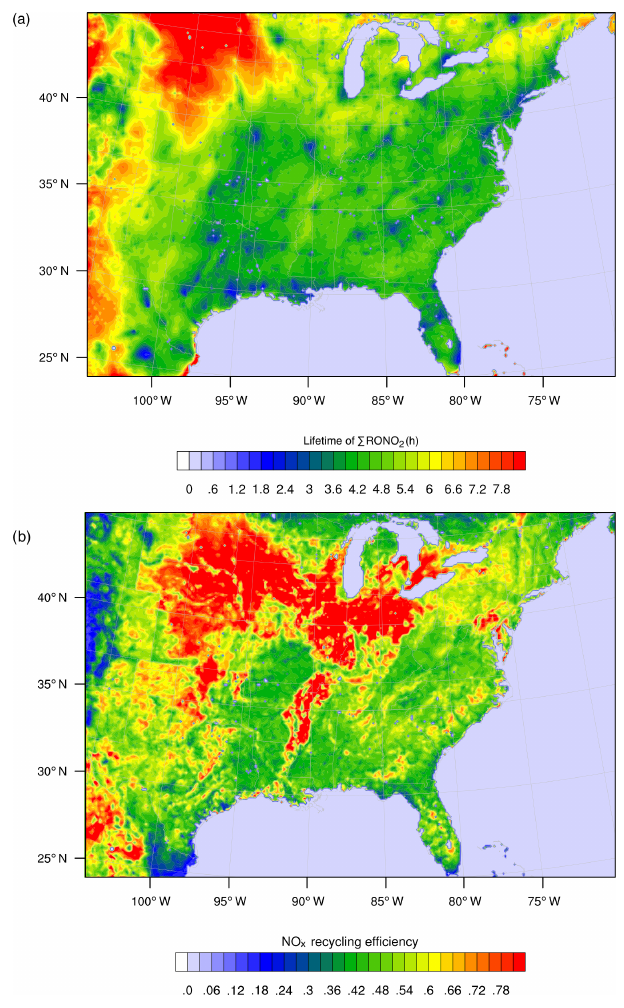
Figure 7. WRF-Chem simulation of RONO 2 chemistry over the southeast United States for summer 2013 as described in Zare et al. (2018). Panel (a) shows the overall lifetime of (cid:54) RONO 2 , defined as the concentration of (cid:54) RONO 2 divided by their chemical loss rate for the daytime boundary layer. Panel (b) shows the average NO x recycling efficiency, defined as the local rate of NO x production from RONO 2 oxidation divided by the rate of RONO 2 production.